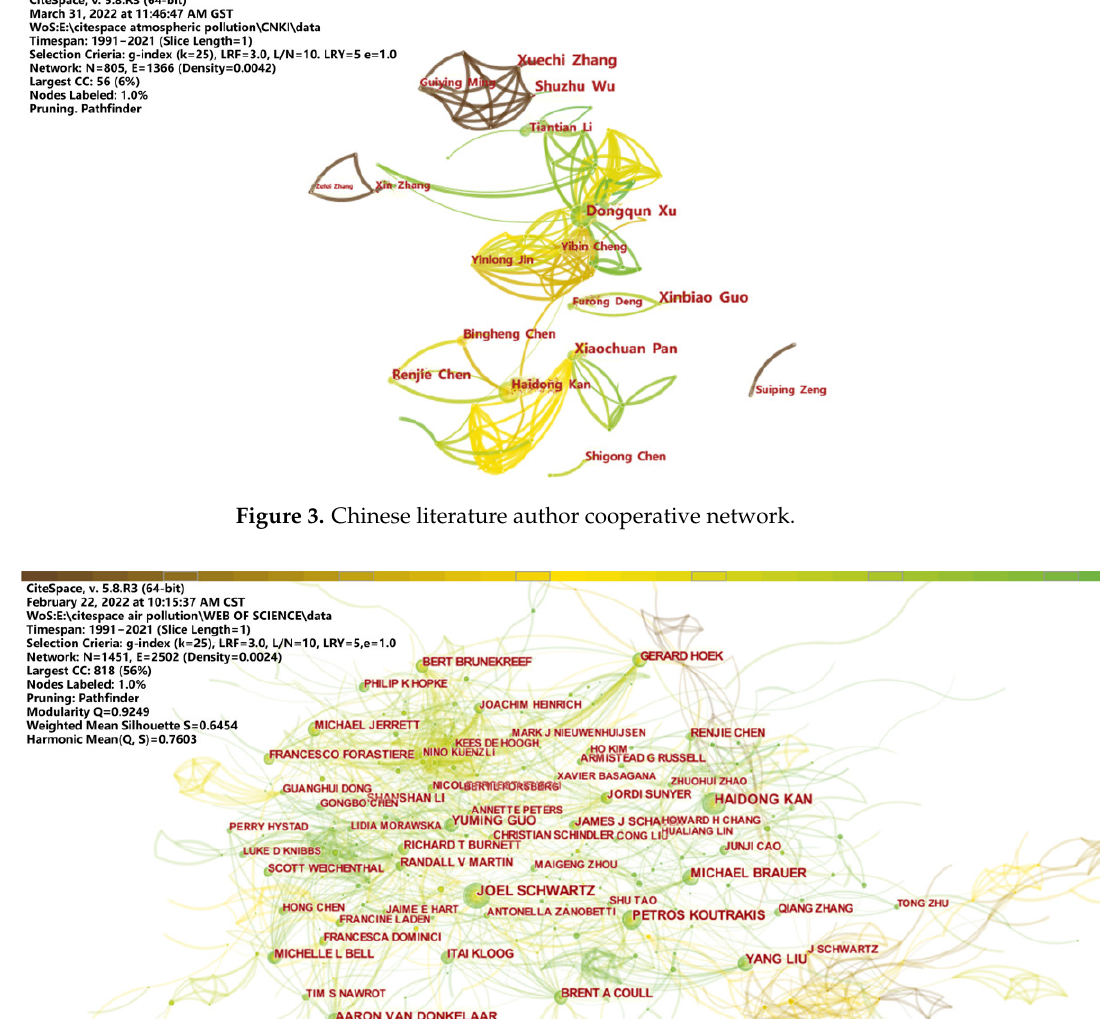
Figure 5. Chinese publication institutions of air pollution and health research.